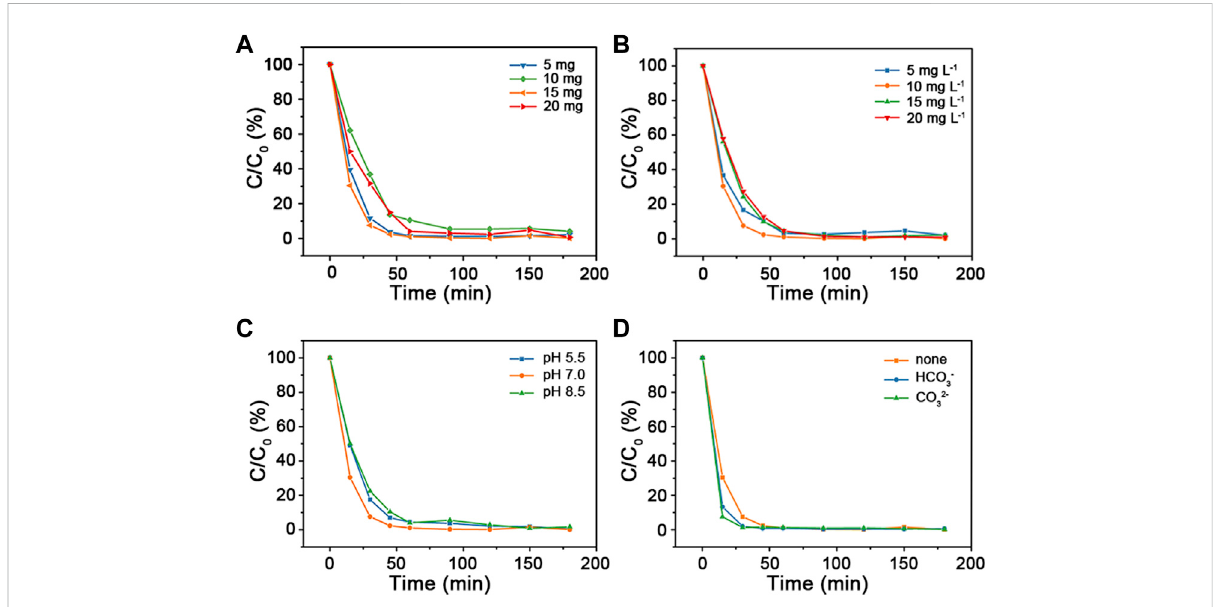
FIGURE 5 (A) Catalytic activities of Cu 2 O@SiO 2 /MnO 2 − PEG for degradation of MB using various catalyst dosage (5 mg, 10 mg, 15 mg, and 20 mg). (B) Alteration of initial MB concentration (5 mg L − 1 , 10 mg L − 1 , 15 mg L − 1 , and 20 mg L − 1 ) in MB degradation. (C) Changes of different pH environment adjusted by HCl and NaOH (pH= 5.5; 7.0, and 8.5) in MB degradation. (D) Catalytic performances of MB degradation co-existence ofinorganic irons